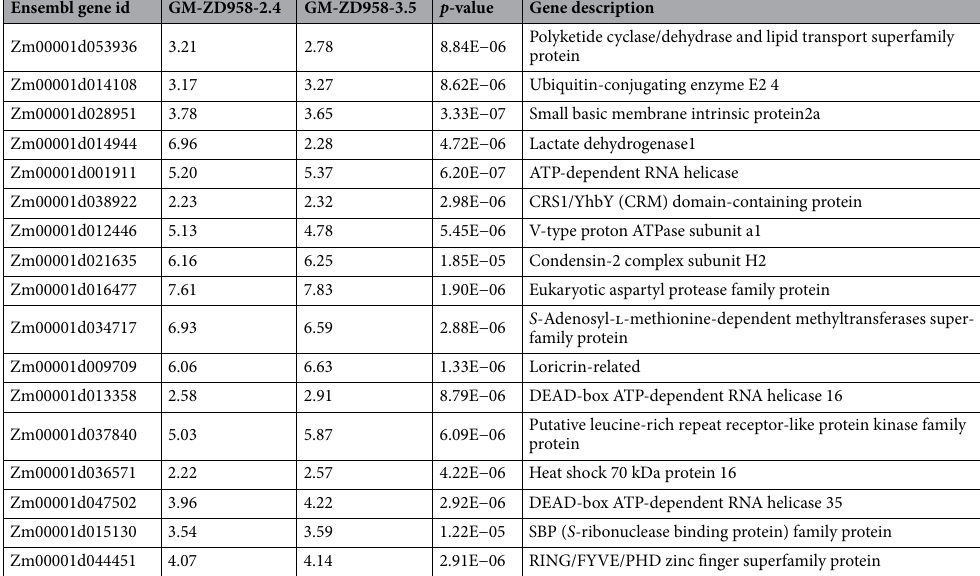
Table 2. Fold change of top 5% differentially abundant genes (DAGs) between two transgenic events of GM-ZD958 relative to non-GM ZD958 (CK).